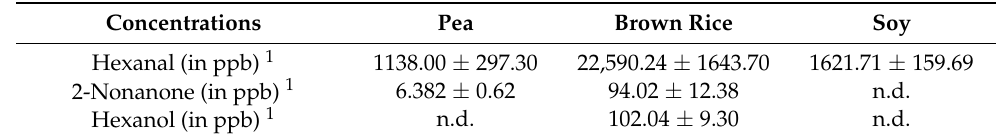
Table 1. Fully quantified concentration of the standard compound (hexanal, 2-nonanone, and hexanol) in plant protein extracts.